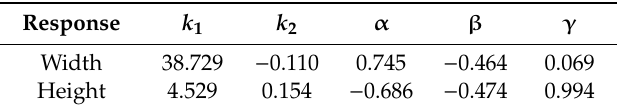
Table 3. Exponents and calibration parameters of regression for width and height; measuring units of the factors as deposited in Table